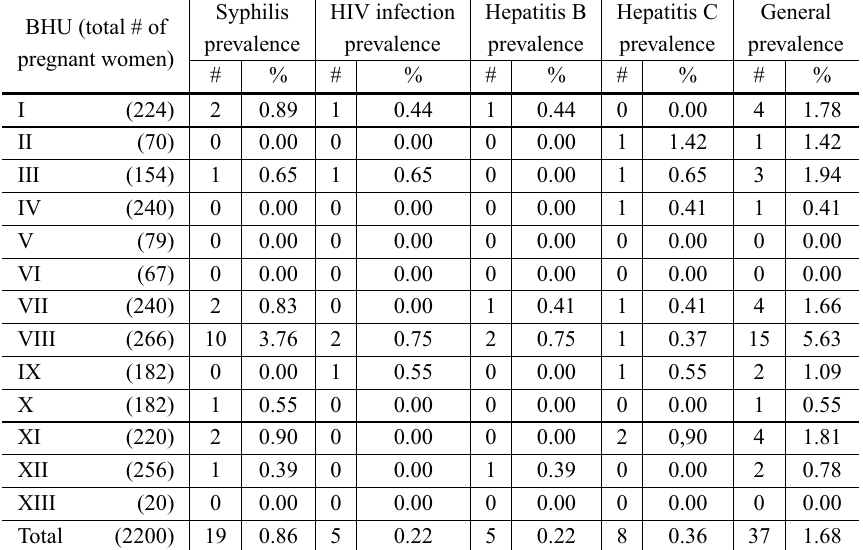
Prevalence of infectious disease (syphilis, Hepatitis B, Hepatitis C, HIV) among pregnant women in thirteen basic health units of the south-east region of São Paulo city, from January to December 2005.